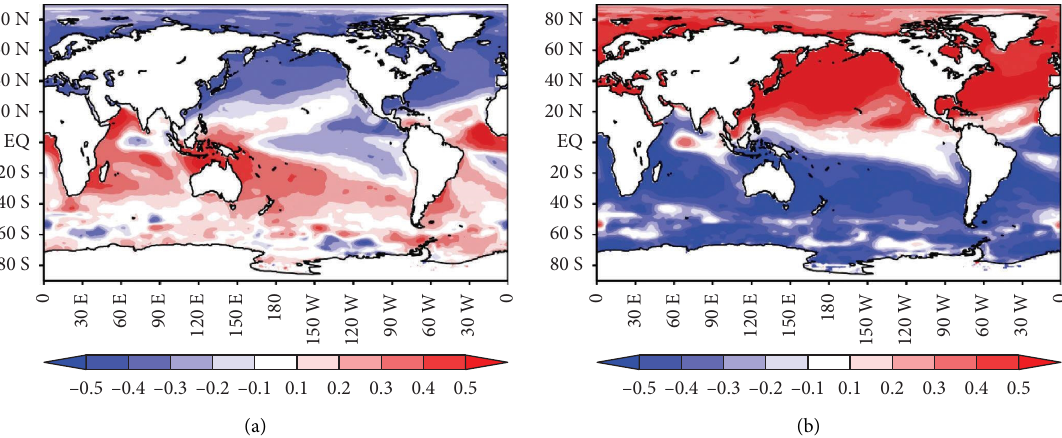
Figure 11: Correlation coefcient ( shaded ) between the SSTanomalies and PC1 (a) and PC2 (b) in period of 1981–2010. (a) Coef SSTand PC1. (b) Coef SST and